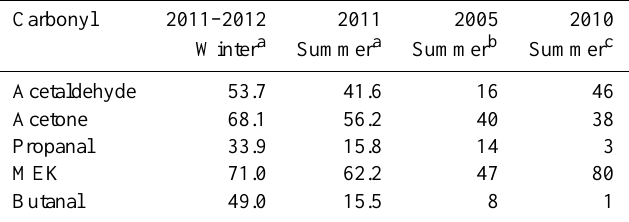
Table 4. Percentages of carbonyl concentrations from primary anthropogenic sources in this study and previous studies in Beijing.